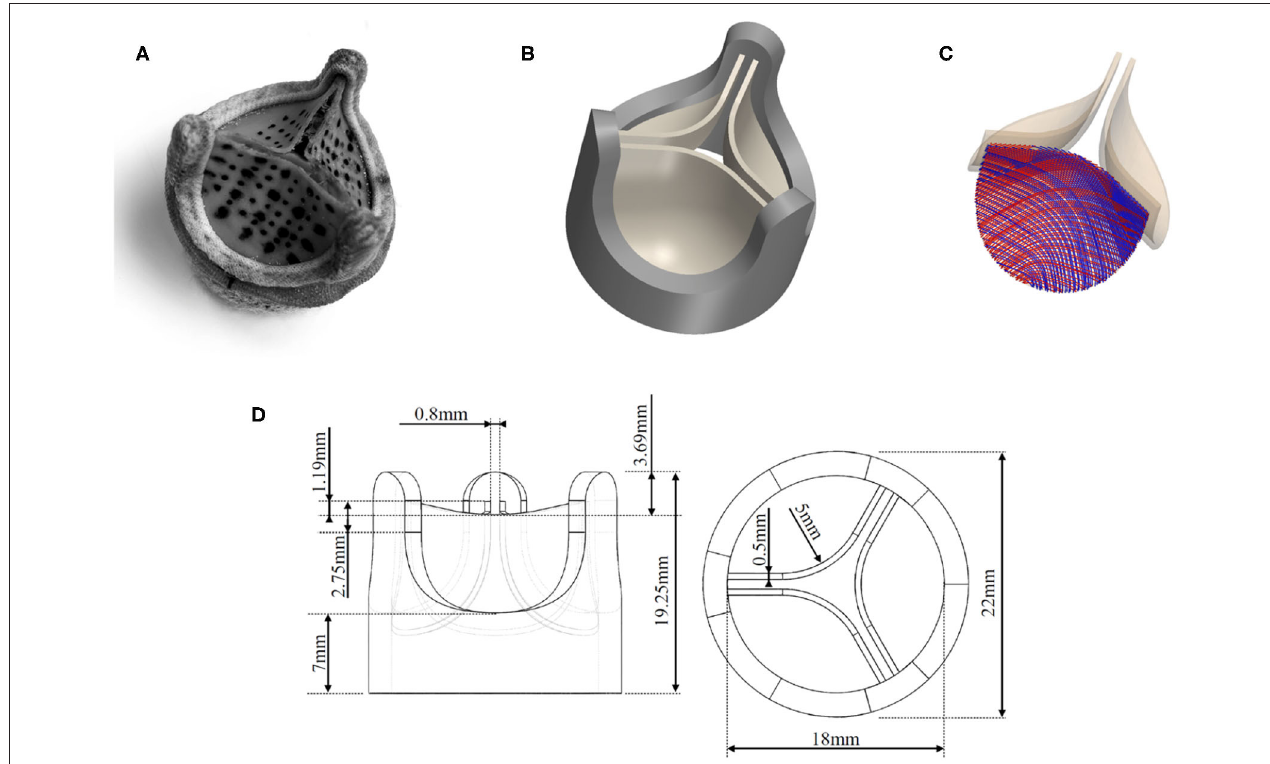
FIGURE 2 | Tri-leaflet bioprosthetic valve model: (A) photo of Edwards Intuity Elite 21 valve by Edwards Lifescience, Irvine, CA, USA, (B) CAD model of the valve, (C) fiber directions in the leaflet tissue, (D) dimensions of the valve model.